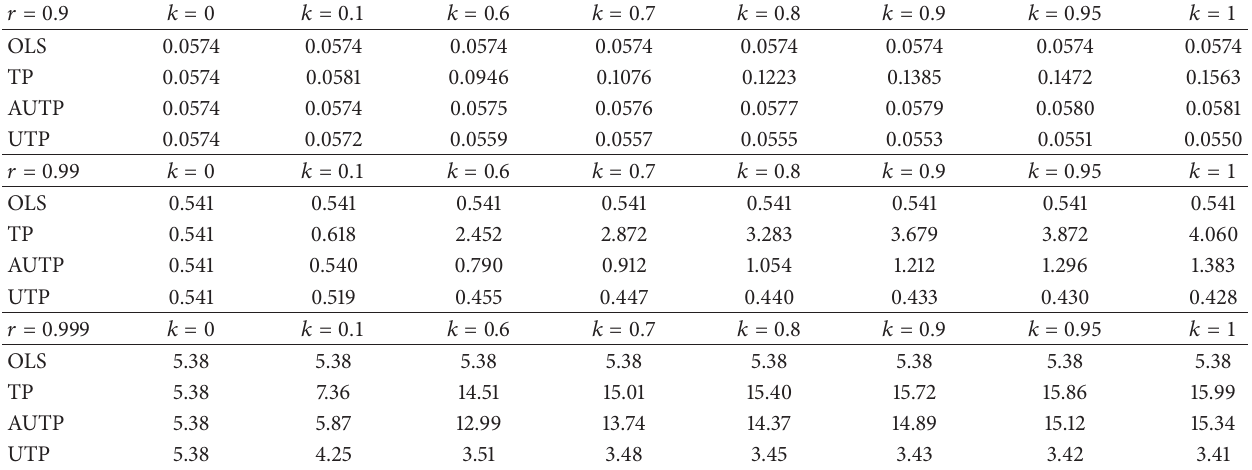
Table 7: Estimated MSE values of OLS, TP, AUTP, and UTP when 𝑛 = 50 , 𝑝 = 6 , and 𝜎 2 = 0.1 .